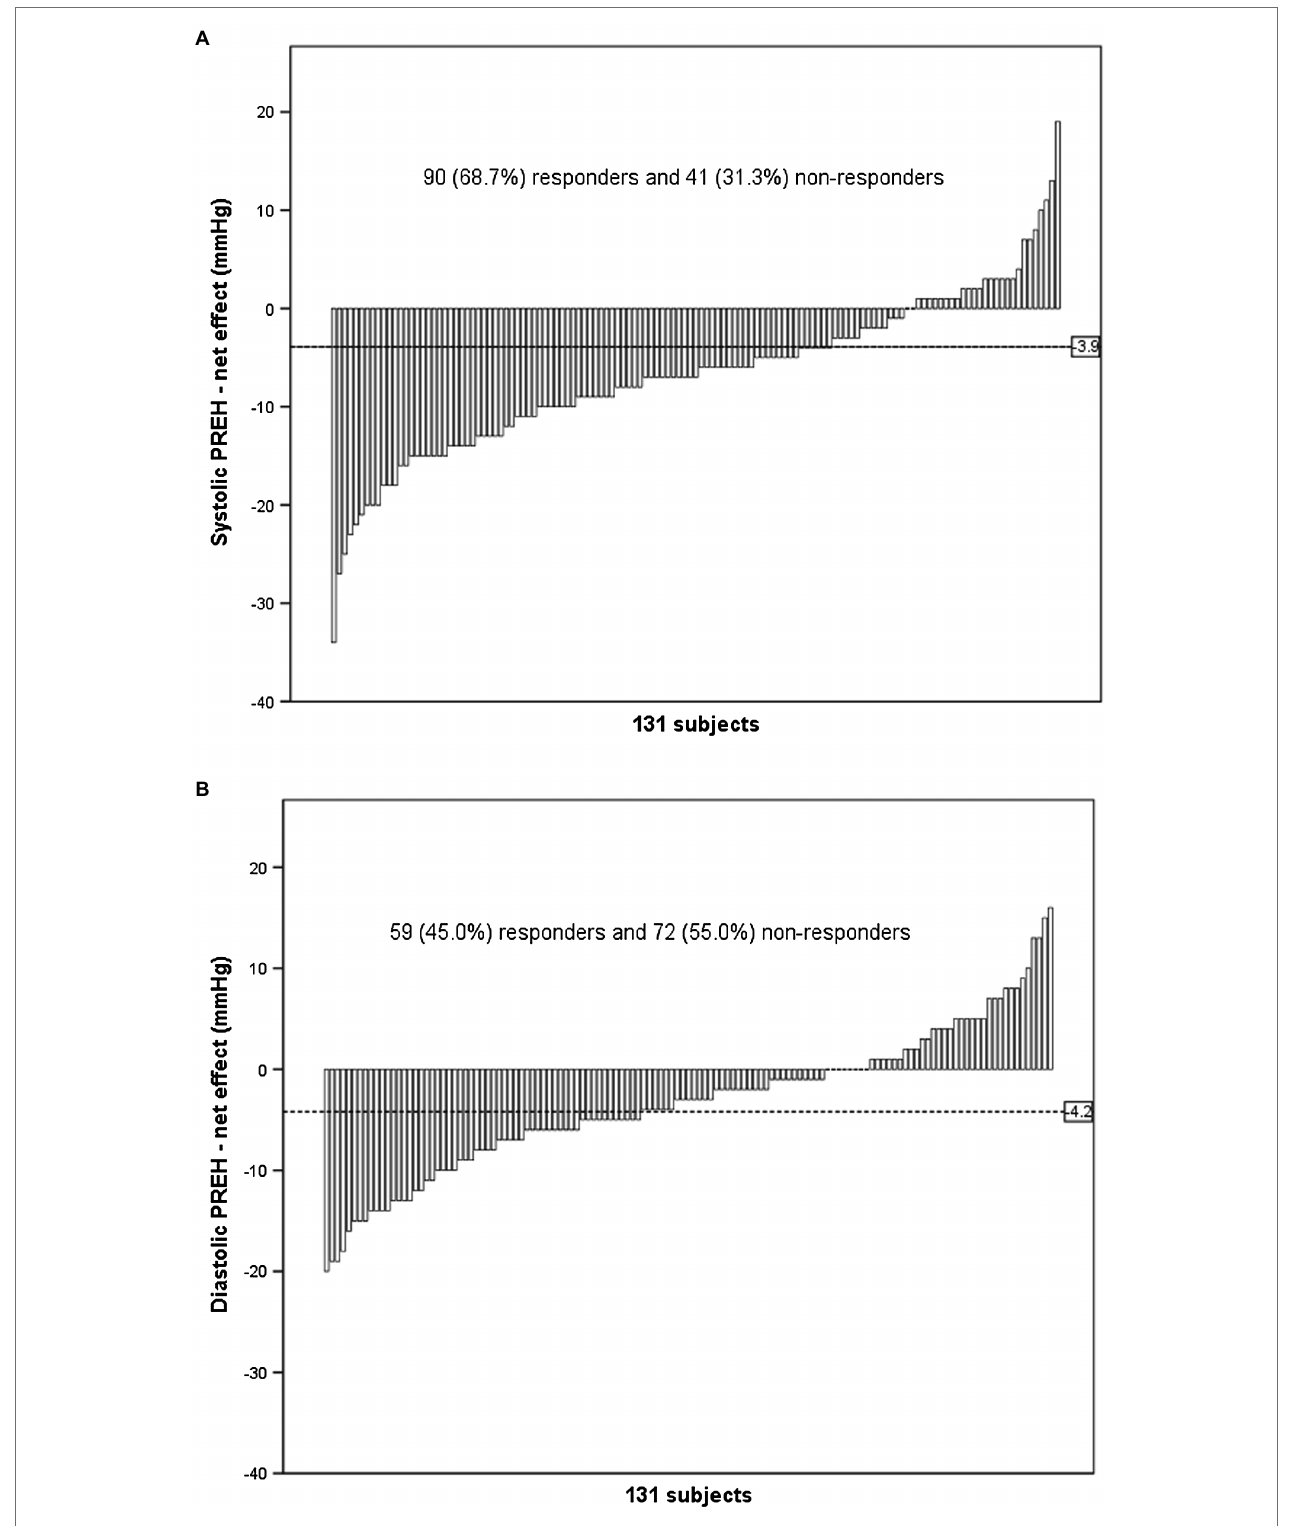
FIGURE 1 | Individual responses of post-dynamic resistance exercise (PREH) calculated by the exercise net effect [(post-exercise BP – baseline BP in the exercise session) – (post-control BP – baseline BP in the control session)]. The dashed line represents the typical error of measurement and individuals that presented PREH greater than this threshold were classified as